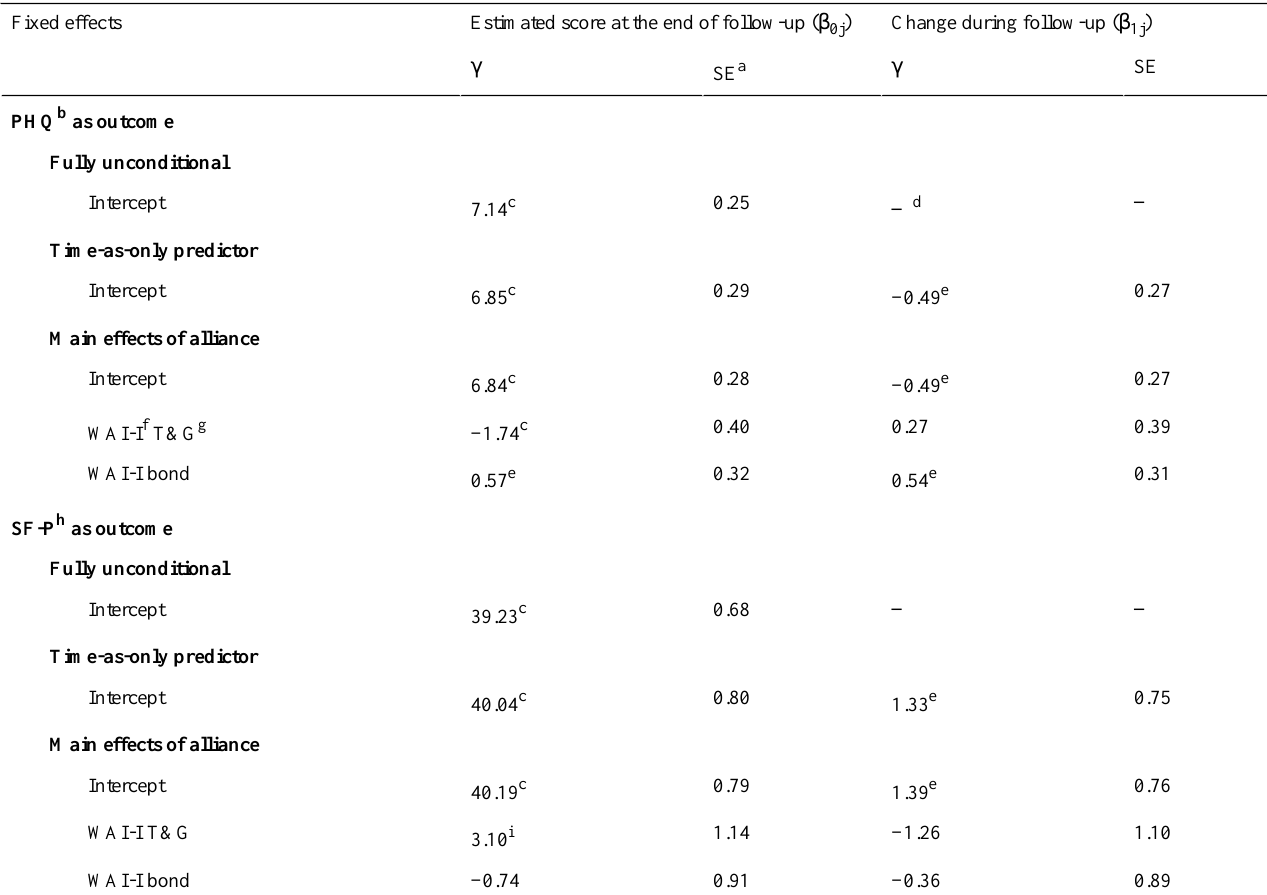
Table 2. Results of the unconditional, time-as-only predictor, and conditional main effect hierarchical linear models.